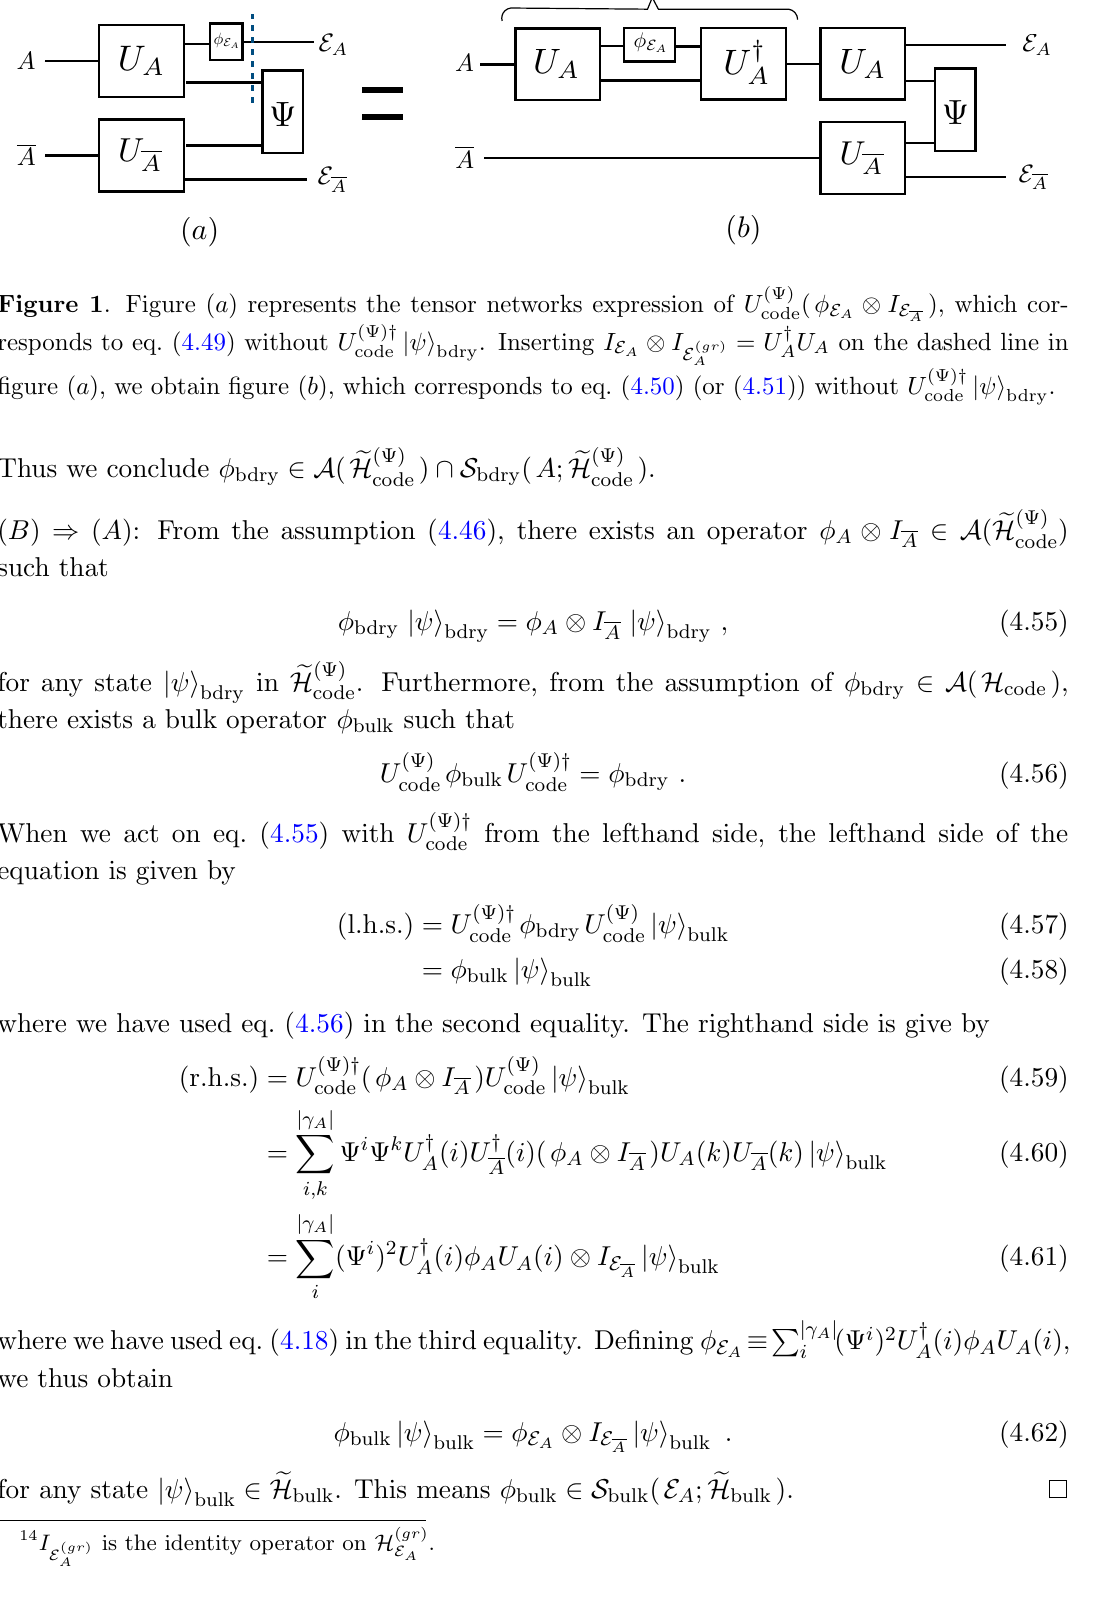
Figure 1 . Figure ( a ) represents the tensor networks expression of U ((cid:9)) responds to eq. (4.49) without U ((cid:9)) y (cid:12)gure ( a ), we obtain (cid:12)gure ( b ), which corresponds to eq. (4.50) (or (4.51)) without U ((cid:9)) y